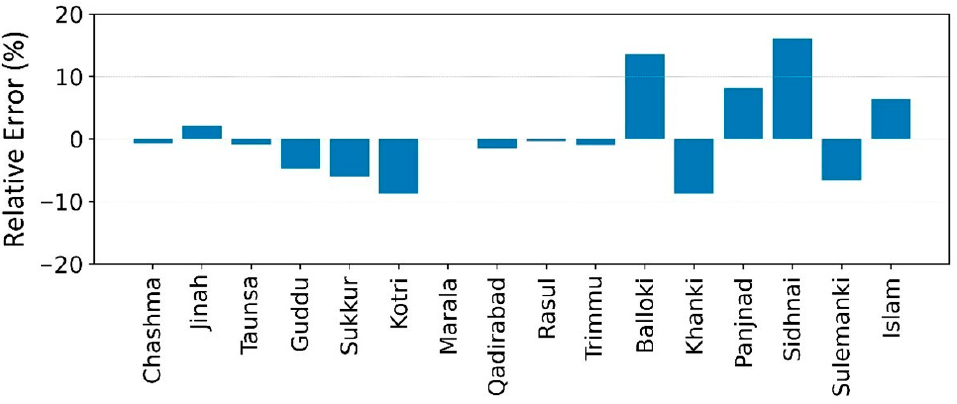
Figure 7. Mean annual modelled relative error % (2002–2012) upstream of barrages.